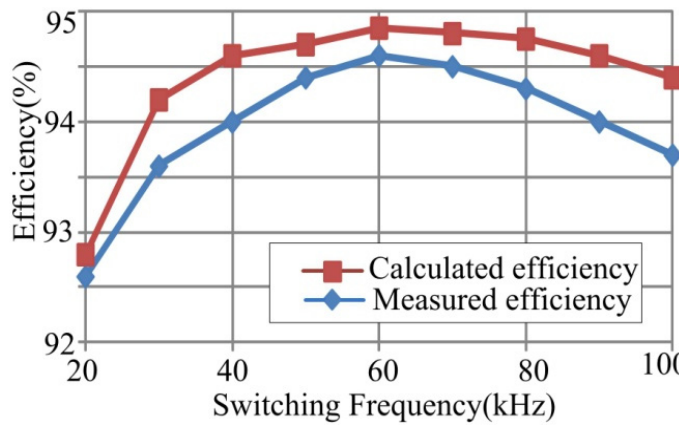
Figure 13. Effect of switching frequency on the efficiency at I o = 5 A. Comparison of results based on the loss model and